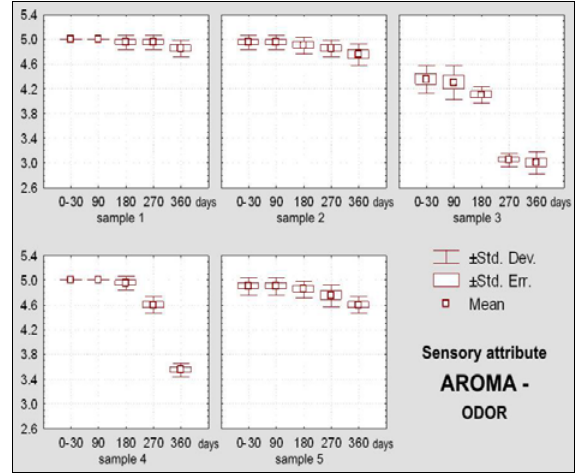
Figure 14 . Box-plots for sensory attribute aroma – odor of dietary